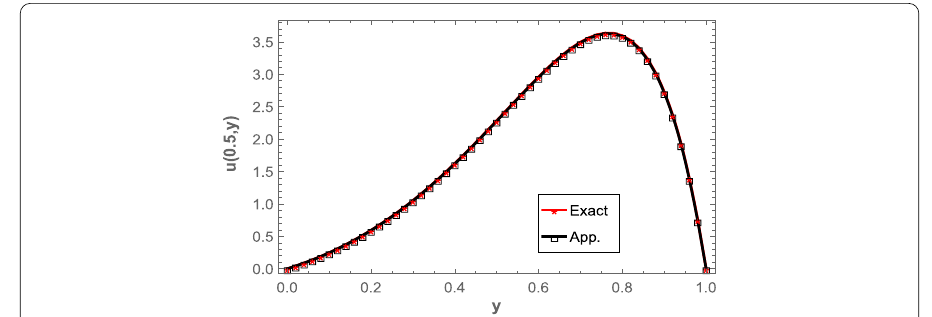
Figure 2 The exact results at x = 0.5 and the numerical results